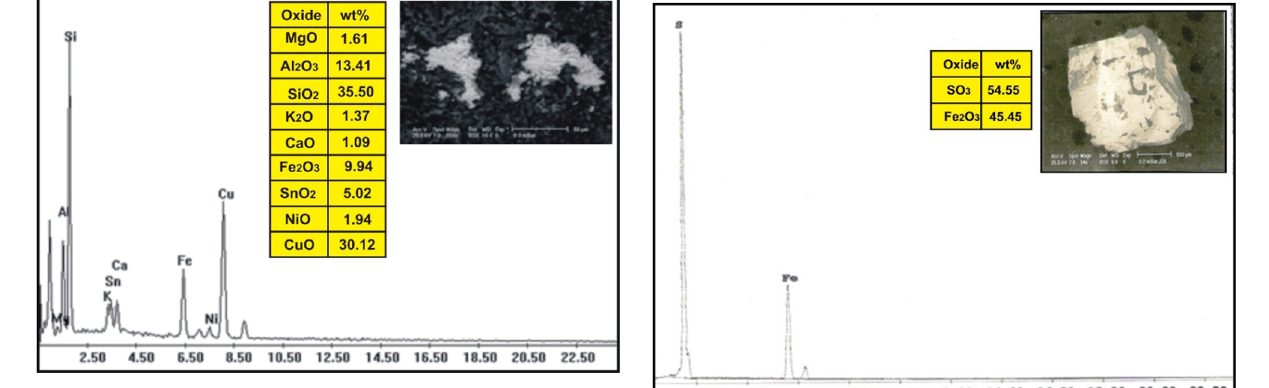
Figure 18: ESEM - EDX analysis of pyrite in dolerite dike at Wadi